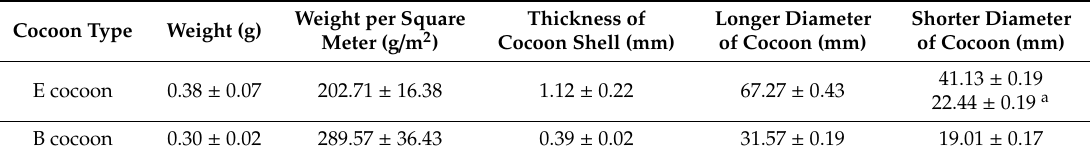
Table 1. Geometrical parameters of the E and B cocoons.